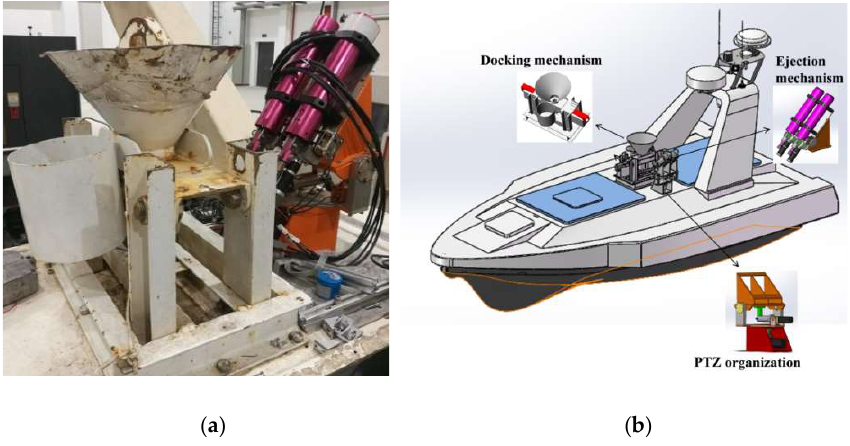
Figure 10. Docking device ( a ) Architectural overview of the docking device. ( b ) Composition of the docking device. Table 2. The test results of the ejection